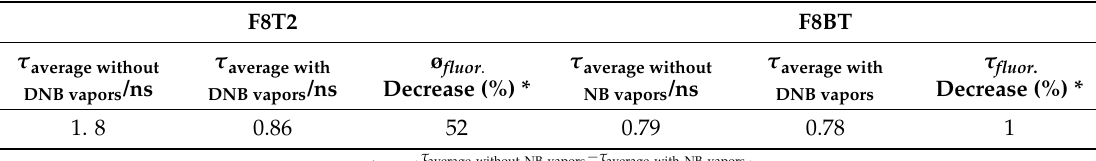
Figure 11. Attenuation of the fluorescence emission of the F8T2 in ethyl cellulose when exposed to NB (1.7 × 10 − 5 M) vapors for 20 s.